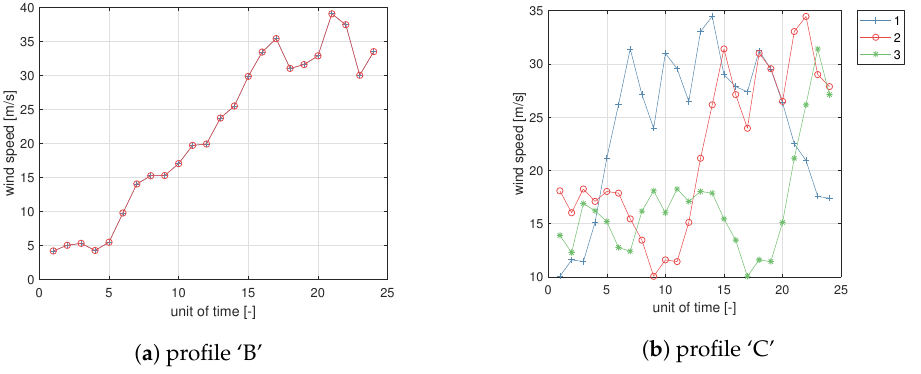
Figure 6. Wind speed spatial